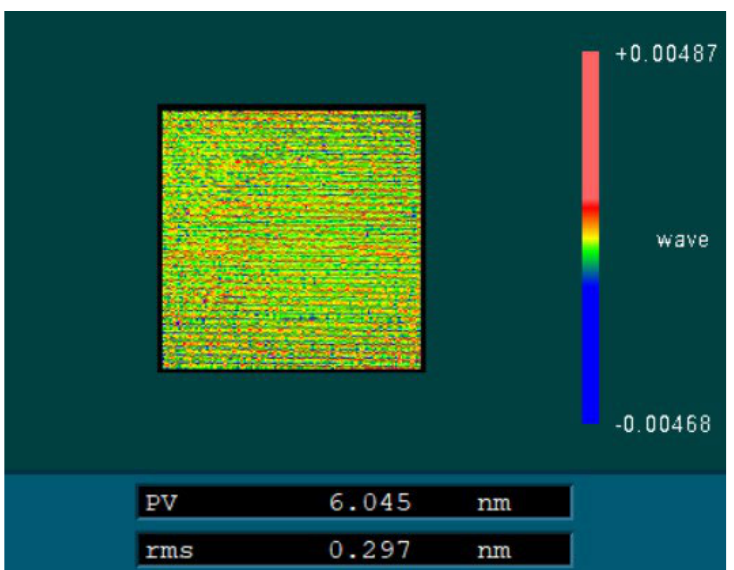
Figure 13. Surface mid-frequency ripple error results before and after magnetorheological polishing repair.